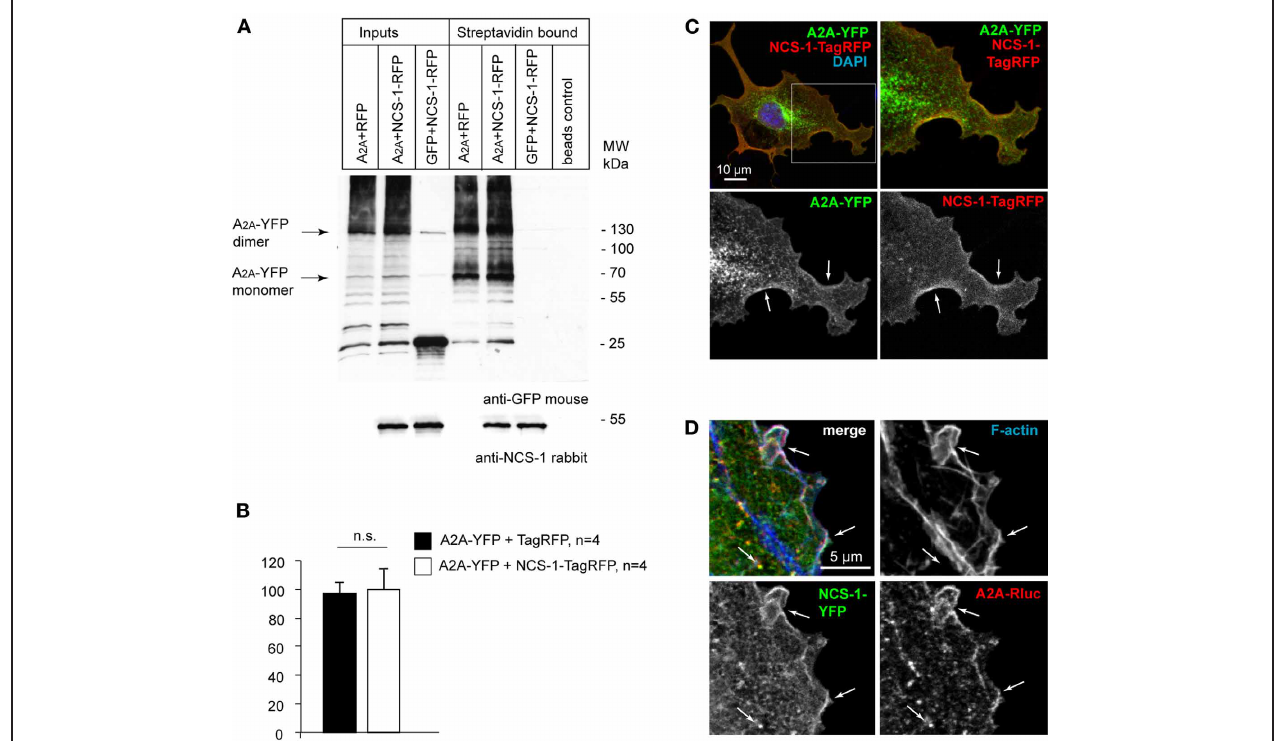
FIGURE 3 | NCS-1 does not interfere with the trafficking and surface expression of adenosine A 2A receptors in the basal conditions (no agonist stimulation). (A) HEK293T cells overexpressing A 2A -YFP alone or together with NCS-1-TagRFP and GFP control co-transfected with NCS-1-TagRFP were labeled with Sulfo-NHS-SS-Biotin for 15min at 4 ◦ C and biotinylated proteins were purified with Streptavidin beads. Detection was done with anti-GFP and anti-NCS-1 antibody. Note the SDS-resistant dimer of A